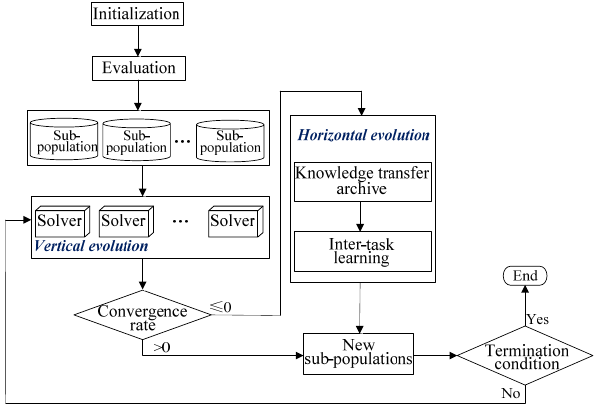
Figure 1. The flowchart of individually guided multi-task optimization (IMTO).